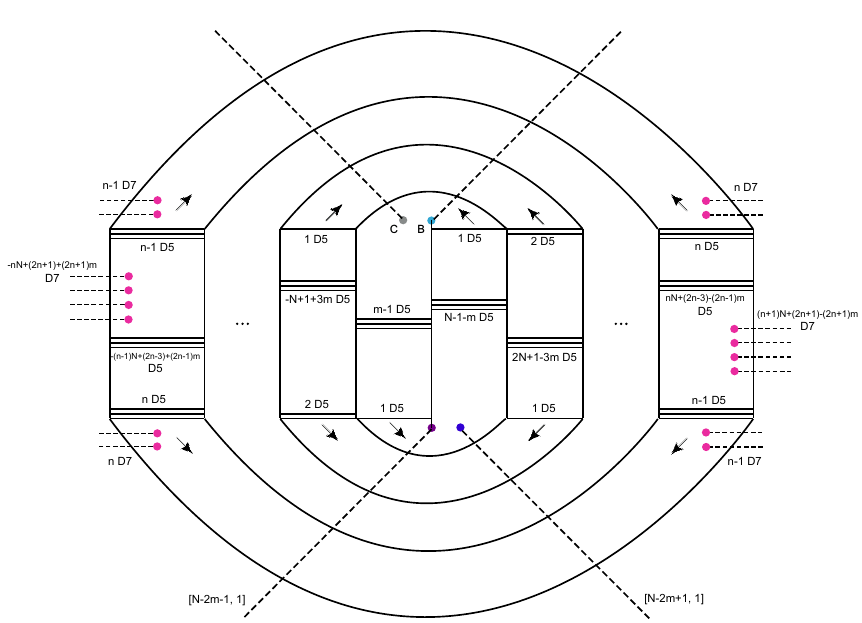
Figure 36 . The diagram after resolving two O 7 X X are moved in such a way that the D5-branes and the D7-branes indicated [ N +2 m 1 ; 1] [ N +2 m +1 ; 1] (cid:0) by the arrows go across the cut.